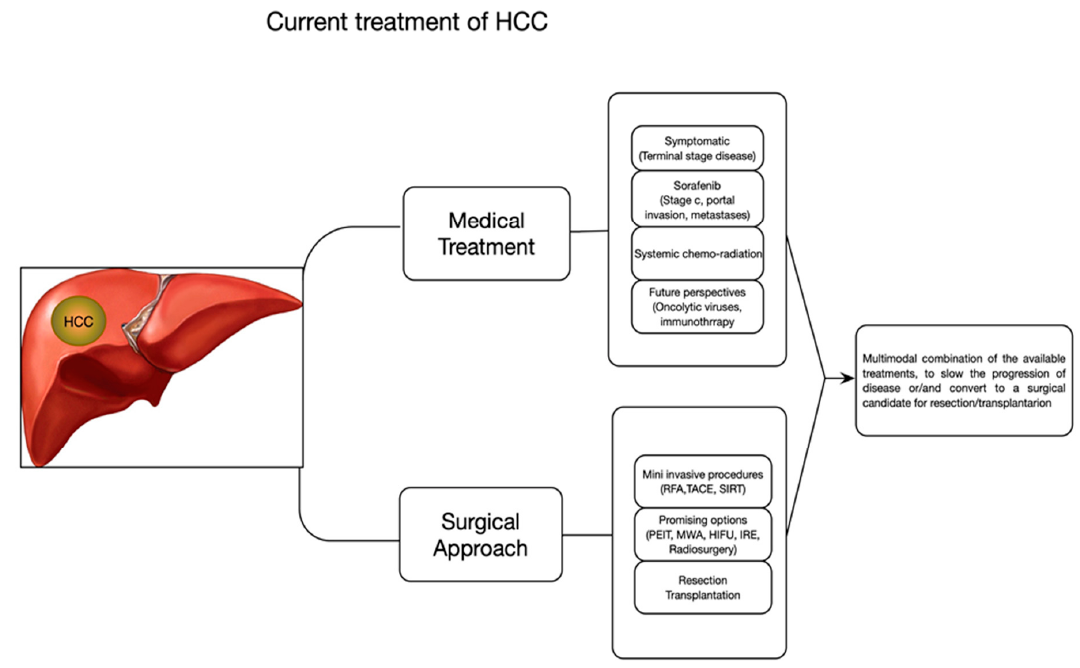
Figure 1. Therapeutic strategies for hepatocellular carcinoma (HCC).